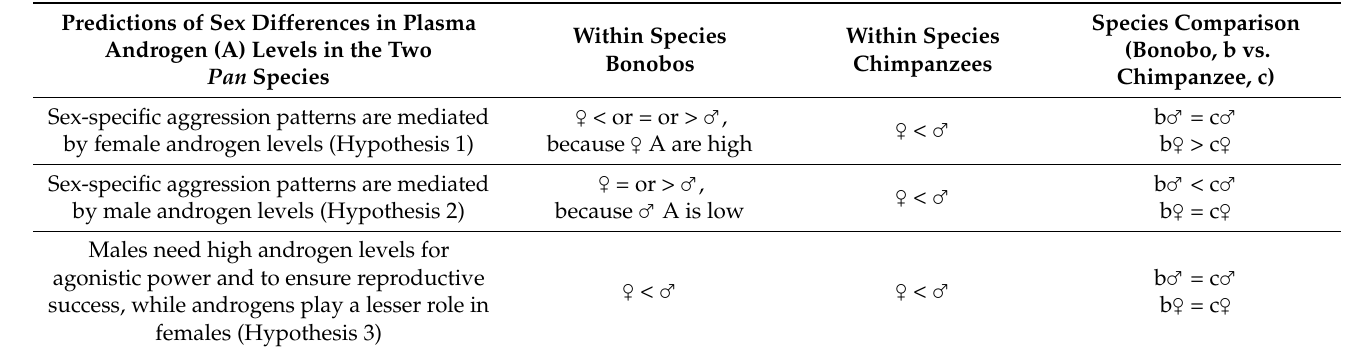
Table 1. Predictions for female plasma androgen (testosterone androstenedione) levels in relation to male plasma androgen levels in bonobos and